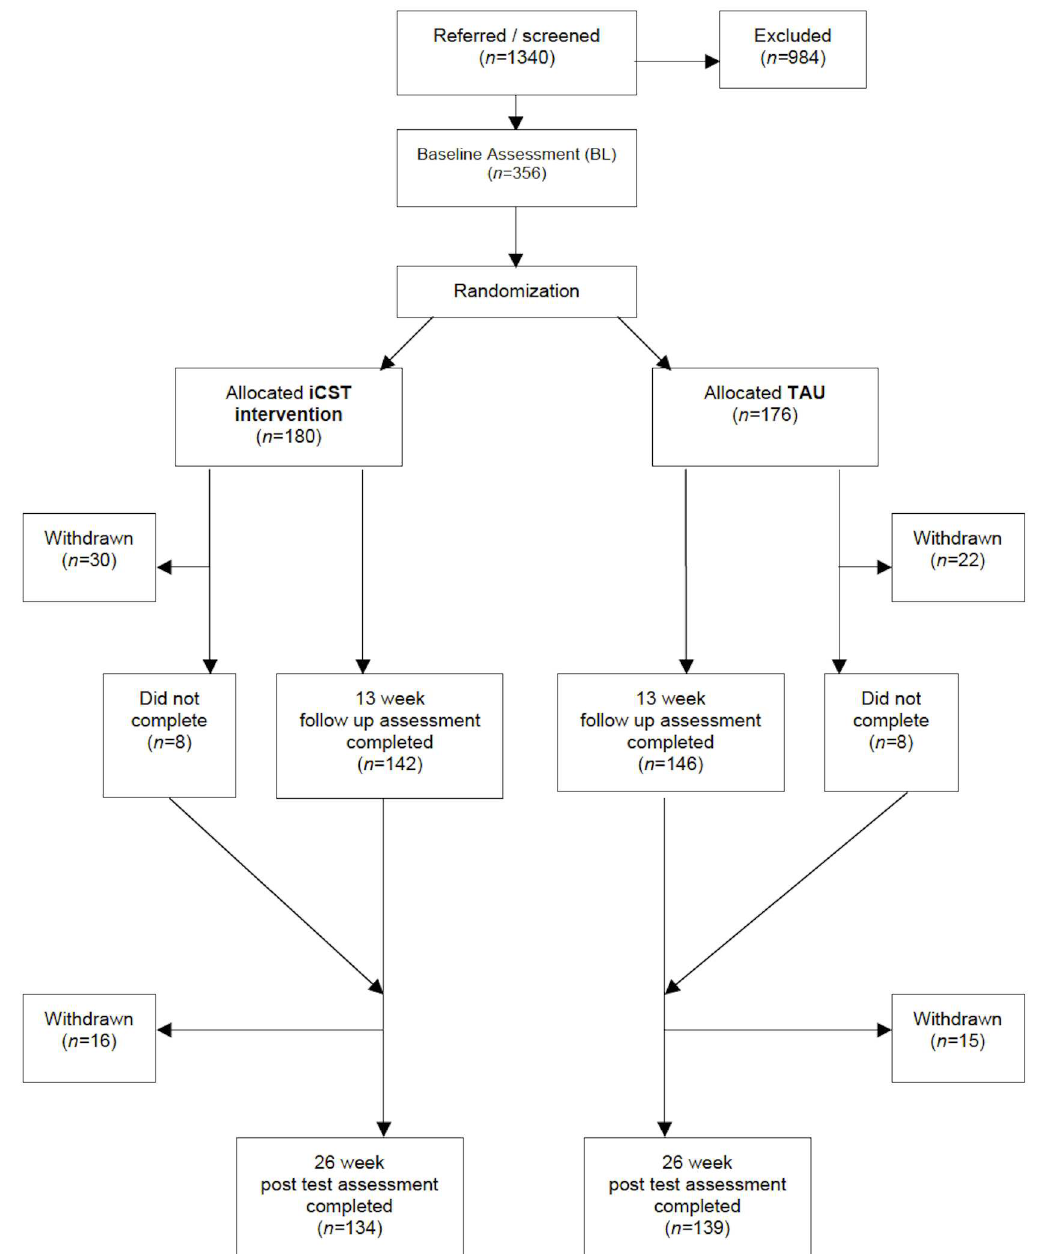
Fig 1. Participant flow through the trial. “Withdrawn” indicatesparticipants’ withdrawalfrom trial and all associated research activities. “Did not complete”indicatesparticipantswho missed 13-wk follow up assessment but returnedfor the 26-wk post